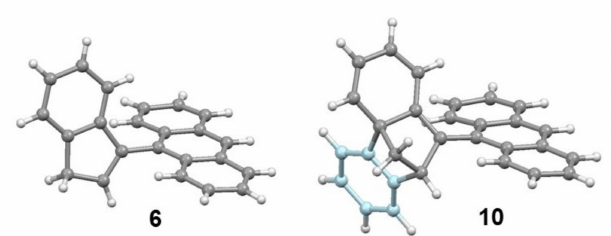
Figure 5. Molecular structures of 9-(3-indenyl)anthracene, 6 , and 10-(anthracen-9 (cid:48) -yl)-[4a,9]-methano-